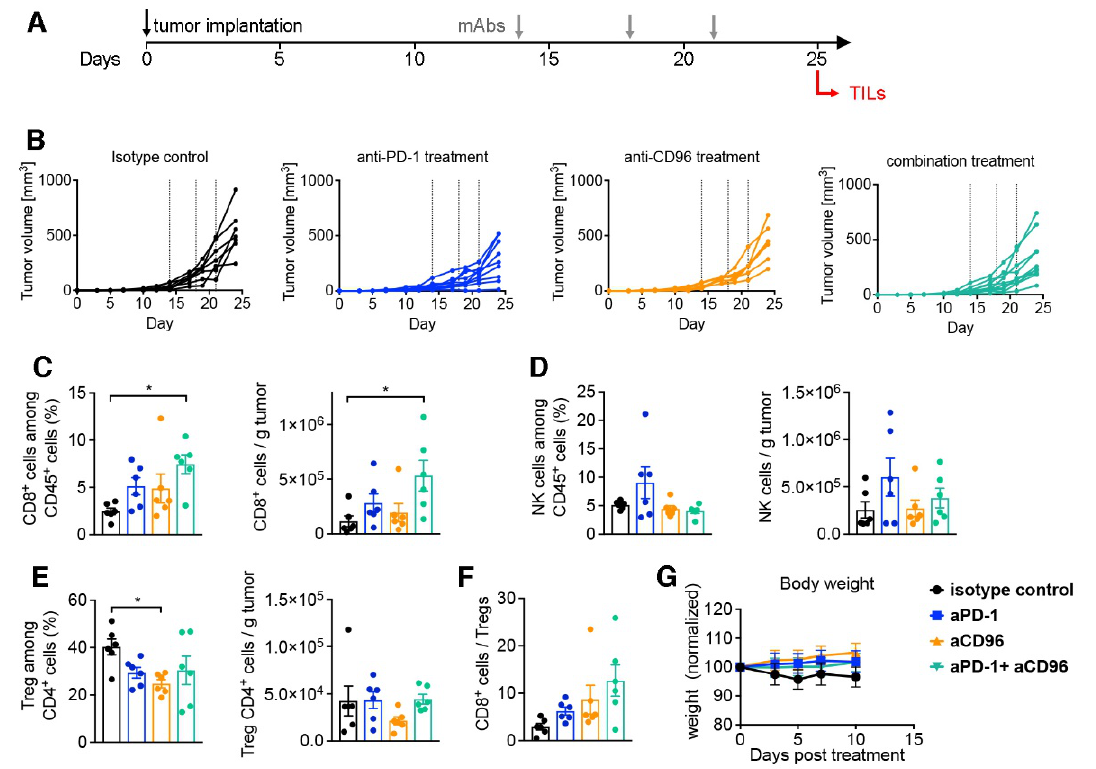
Figure 8. Analysis of tumor infiltrating lymphocytes in mice treated with mAbs. C57BL/6NTac mice were injected s.c. with MC-38 tumors on day 0; mAb treatment commenced at a delayed therapeutic setting 13 days later. Tumors were harvested on day 25 for flow cytometric analysis. ( A ) Schematic of experimental outline; ( B ) tumor volumes are shown for mice under the respective treatment. Dotted lines indicate treatment time points. CD8 + cells ( C ), NK cells ( D ) and regulatory CD4 + Treg cells ( E ) were quantified in tumor tissues and displayed both as frequency and number; ( F ) ratio of CD8 + T cells to CD4 + Treg cells; ( G ) weight chart normalized to weight at treatment initiation expressed as mean ± SEM ( n = 6). Bar graphs in ( C – F ) are displayed as mean ± SEM ( n = 6) with symbols reflecting individual mice. * p < 0.05, one-way ANOVA followed by Tukey’s multiple comparison test.